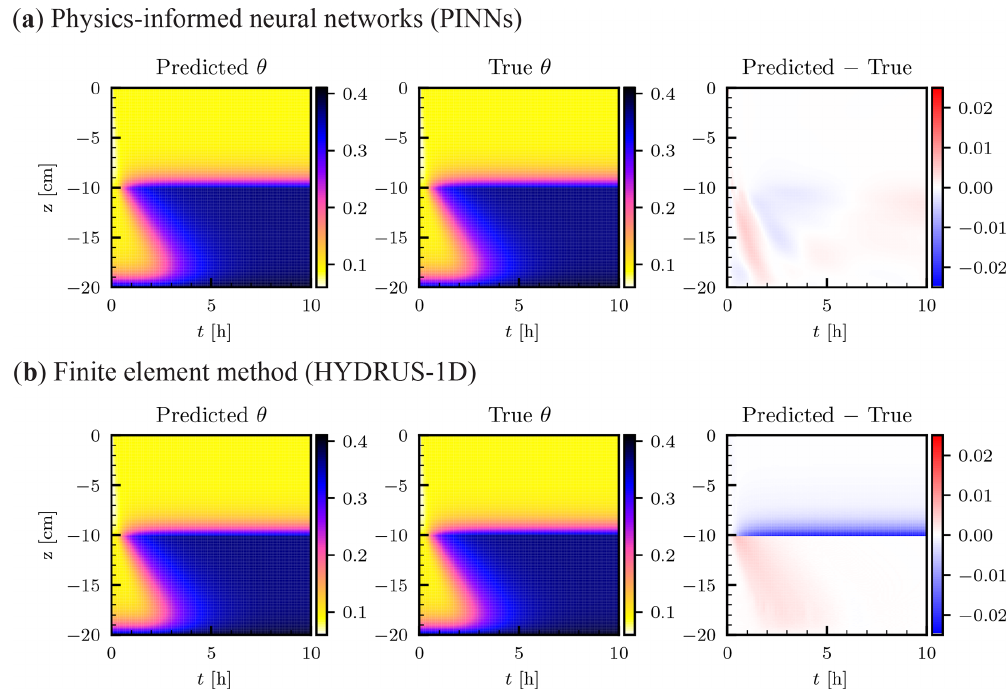
Figure 11. Heterogeneous soil. The saturated conductivity K s is 10.0 and 1.0cms − 1 for the upper and lower layer, respectively. (a) Physics- informed neural network (PINN) solution in terms of volumetric water content θ [–] obtained by two neural networks of five hidden layers with 50 units with the layer-wise adaptive activation function (left column). True analytical solution (center column) is given by Srivastava and Yeh (1991) (see Sect. 2.2.2), and the difference between the PINN and true solutions is shown in the right column. (b) Numerical solution by a finite element method was obtained with a spatial mesh of d z = 0 . 1cm and a time step d t = 0 . 01h using HYDRUS-1D (Šim˚unek et al., 2013).